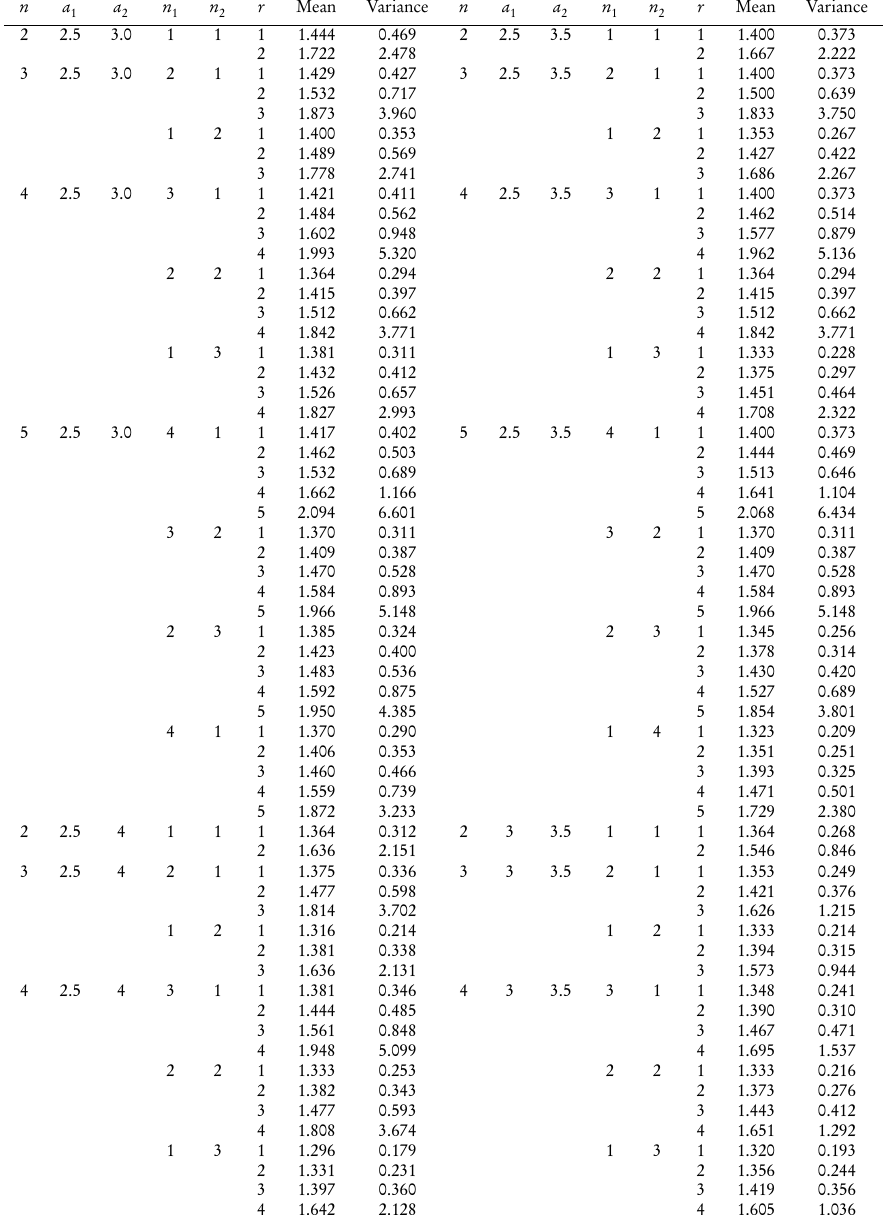
= 2.5 ( 0.5 ) 3.5, a = 3 ( 0.5 ) 4 and n 1 2 2 ≤ n ≤ 5